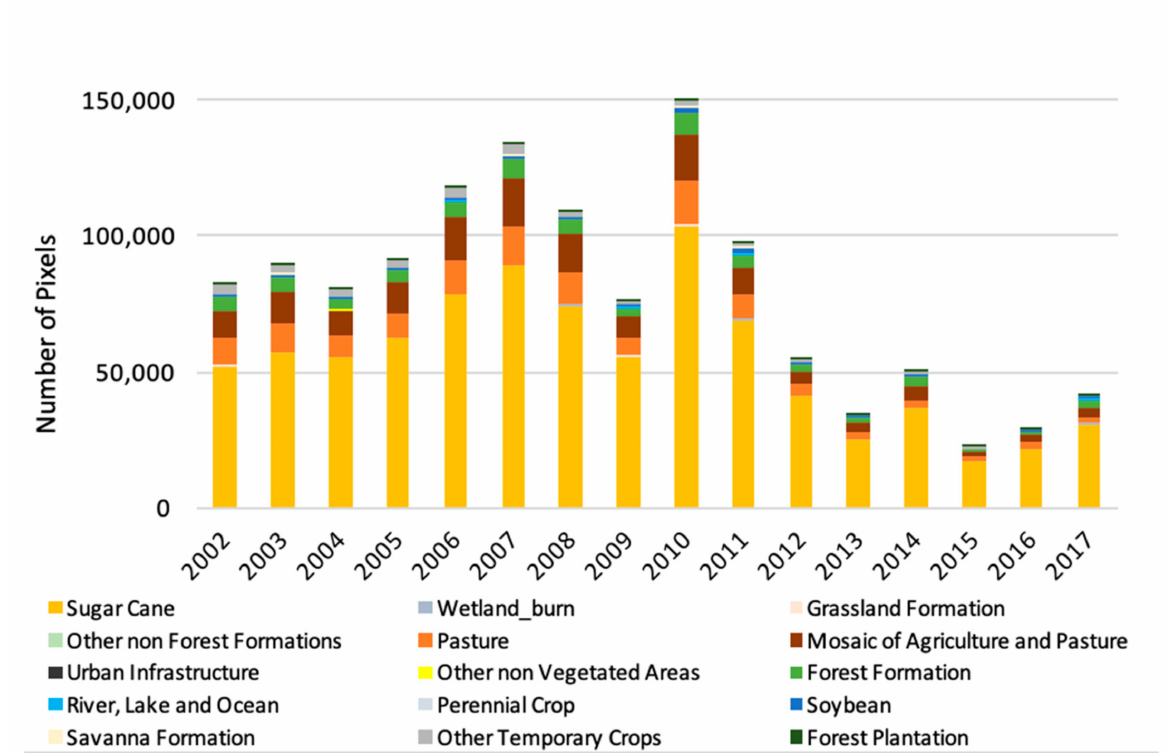
Figure 8. Stacked bar chart of burned pixel counts for each land use type and each year, which highlights the decline in fire events during the study